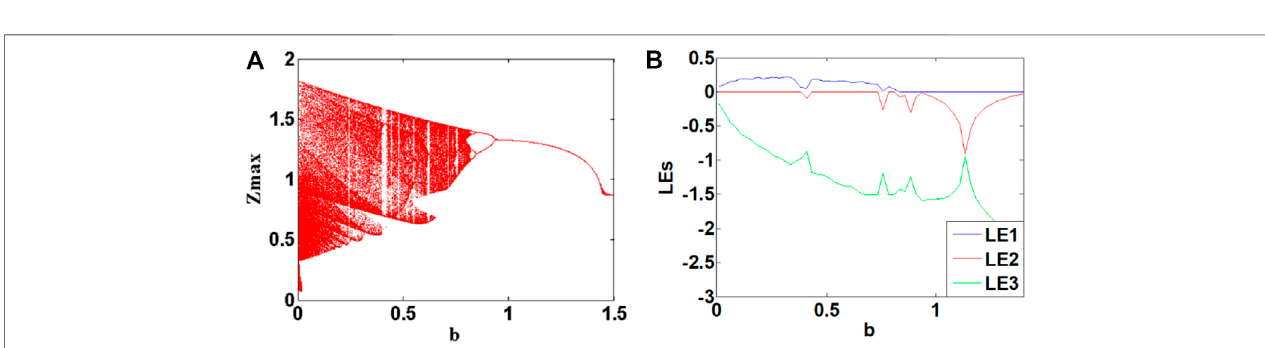
FIGURE4| BifurcationandLyapunovexponentsdiagramsofoscillator(2)with b (cid:1) 0.5, c (cid:1) 1.7, d (cid:1) 2.4andtheinitialconditionsis(1,0,1)whentheparameter a isin[0.5,3]. (A) bifurcation, (B) Lyapunov exponents.